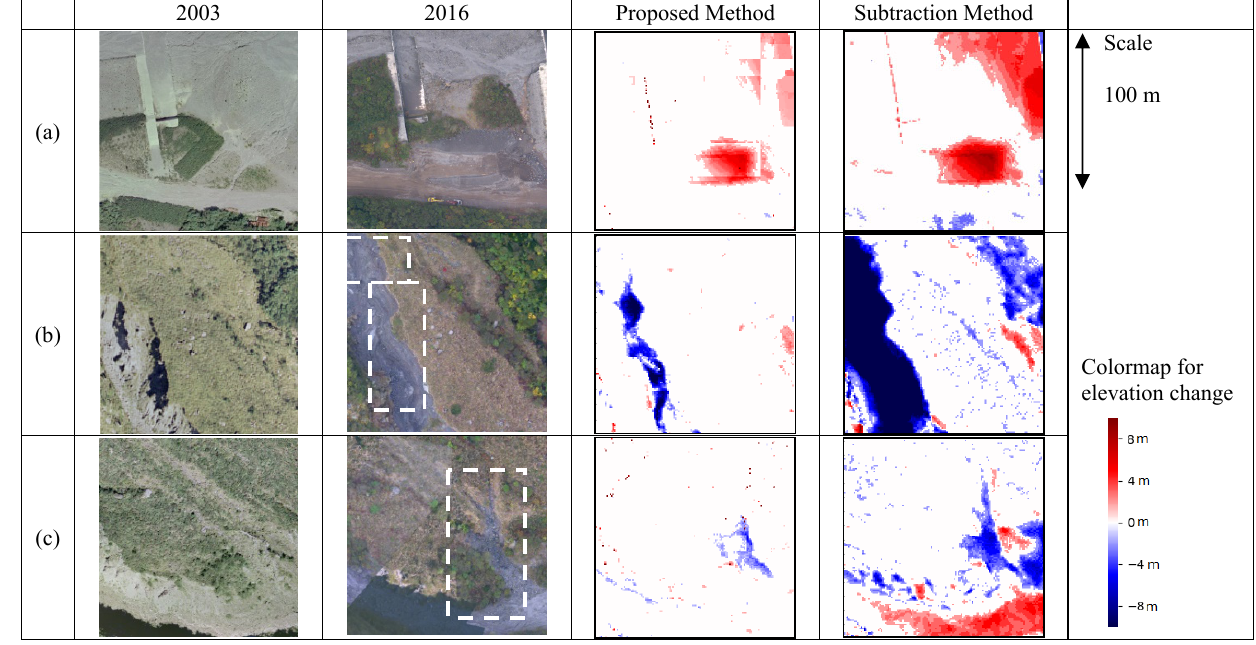
Figure 3 . Comparison of the results of the proposed method and subtraction method (DEM).